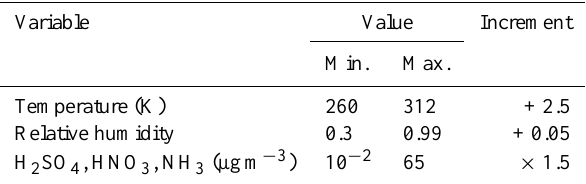
Table 5. Look-up table used for the calculation of the thermody- namic equilibrium with ISORROPIA. The minimum and maximum values represent the range of the values calculated. Their values are defined to cover a large range of possible meteorological situations. In the case of temperature, relative humidity or concentrations less than the minimum or up to the maximum, the thermodynamic equi- librium is chosen as the value corresponding to the last defined value (minimum or maximum). The increment is defined to ensure a real- istic linearity between two consecutive values and for the interpola- tion. It may be an additive (+) or a multiplicative ( × ) increment.